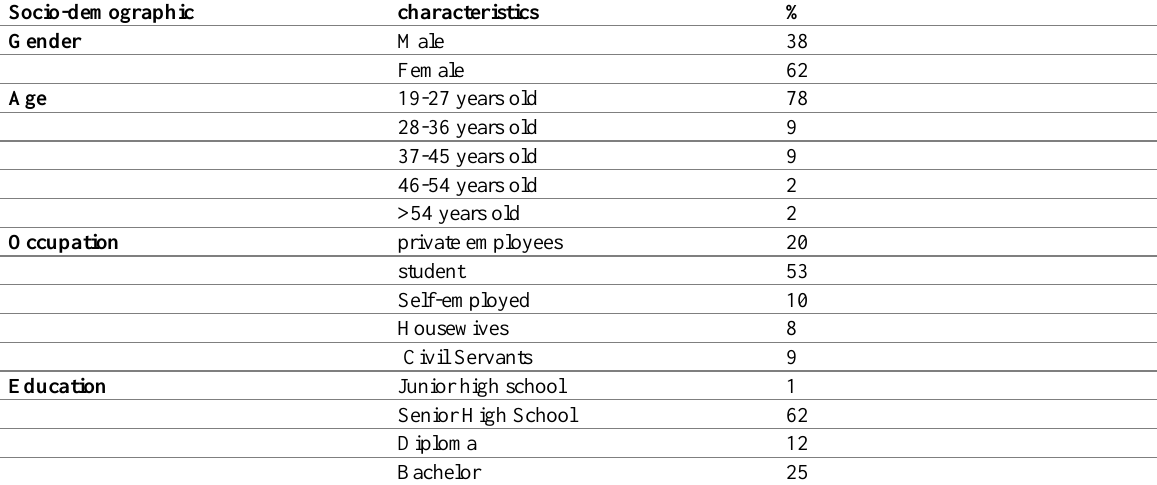
Table 1: Characteristics of the sample (% of respondents, n= 100)